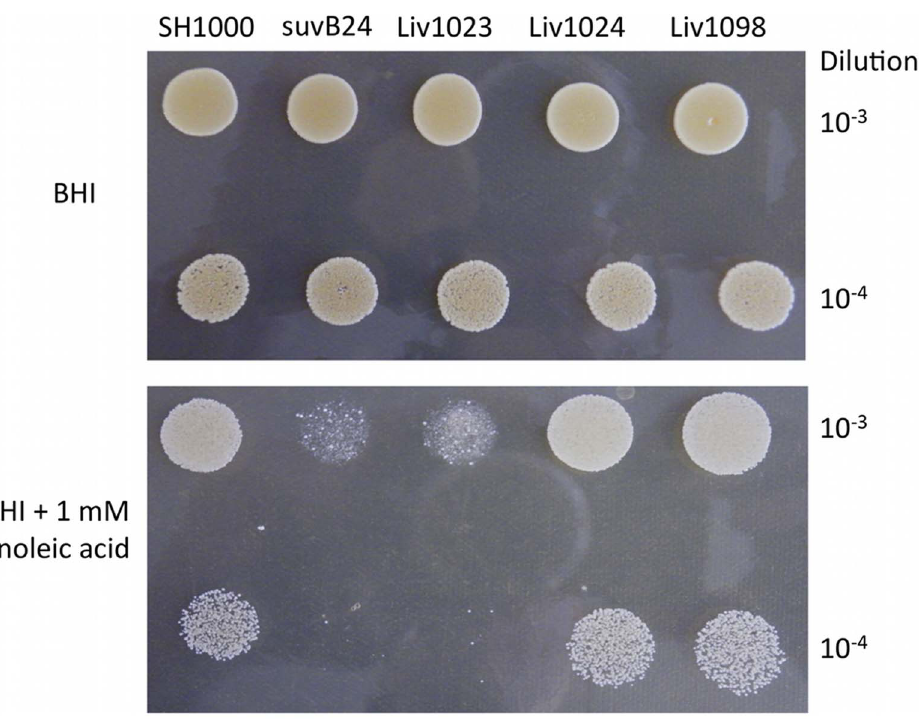
Figure 2. Comparative survival of S.aureus strains. Growth of dilutions from overnight cultures on BHI agar in the presence and absence of 1 mM linoleic acid. SuvB24 (SH1000 mtlD ::Tn 917 ) and Liv1023 (SH1000 mtlD :: tet ) displayed . 500-fold reduced survival on linoleic acid relative to wild type (SH1000), Liv1024 (SH1000 mtlABFD :: tet ) and the complemented mutant strain Liv1098 (SH1000 mtlD :: tet pMJH71).